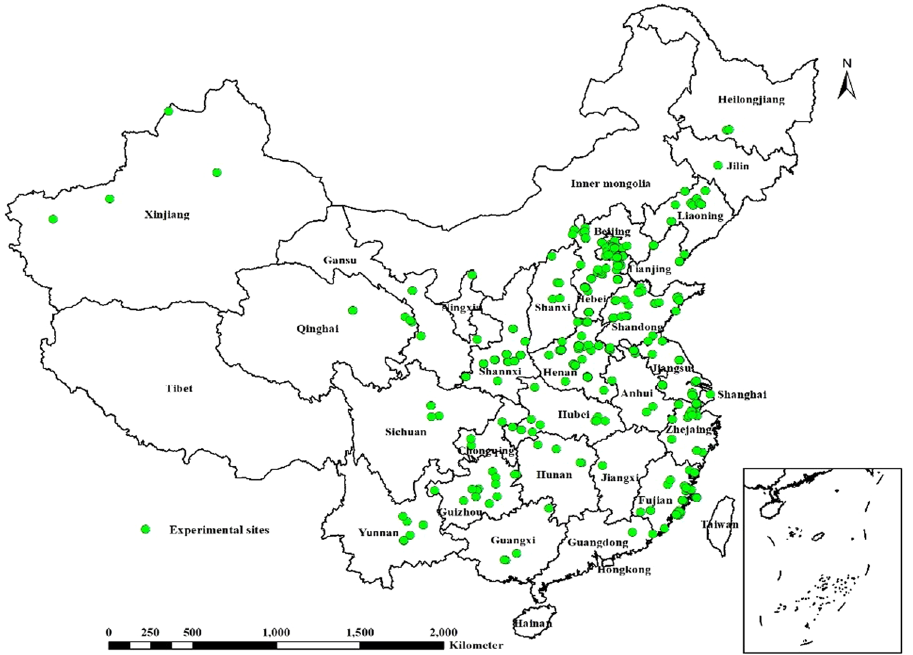
Figure 1. Geographical distribution of experimental sites for radish cultivation in China